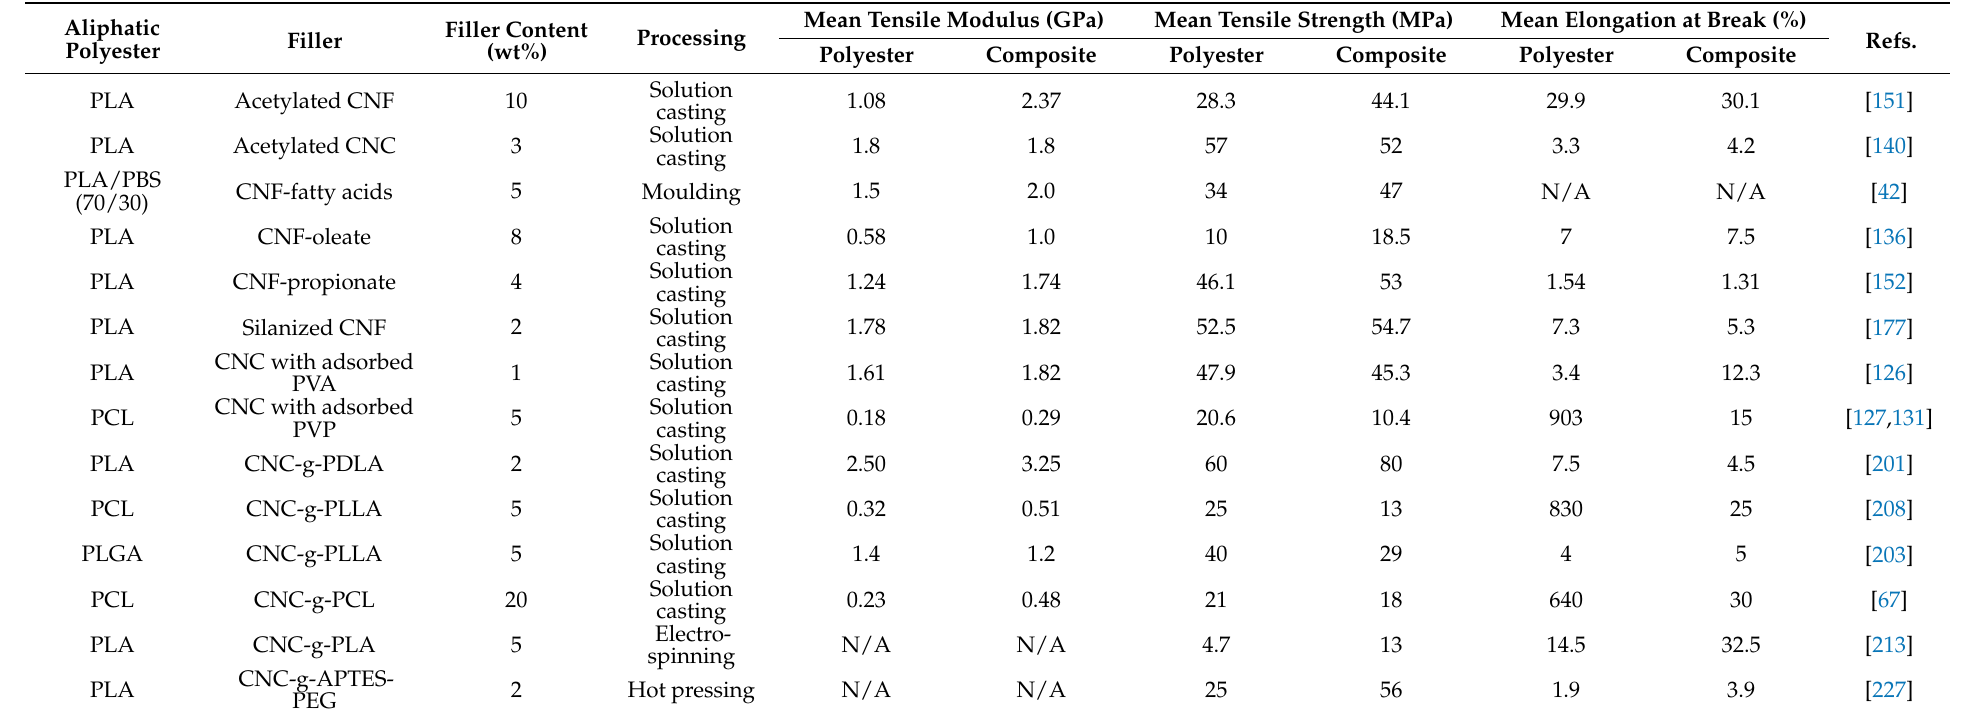
Table 10. Selected studies on the tensile properties of aliphatic polyester/cellulose